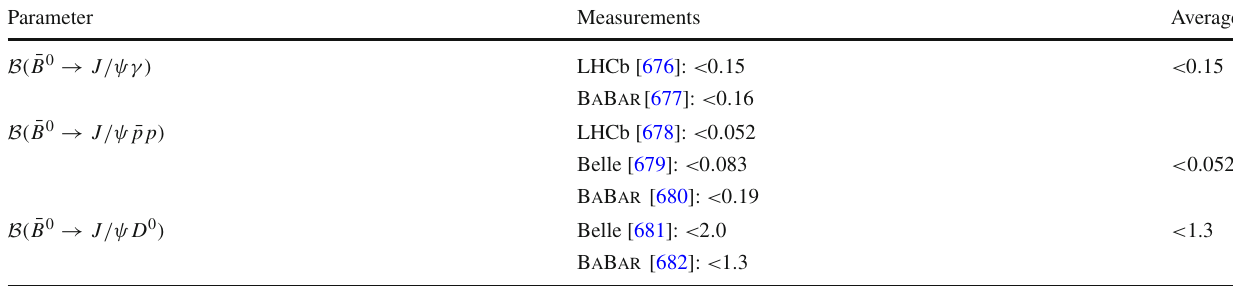
Table 121 Decays to J /ψ and photons, baryons, or heavy mesons [ 10 − 5 ] Parameter